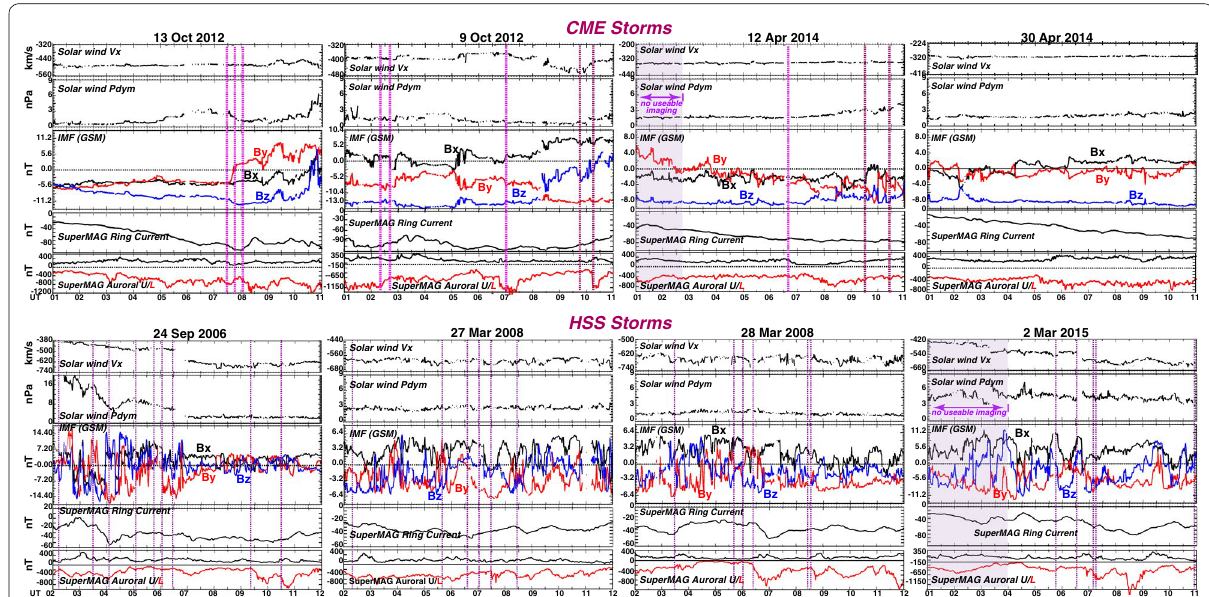
Fig. 2 Solar wind and geomagnetic parameters for the four of our selected CME events having the smoothest southward IMF Bz during the period of ASI viewing. The same parameters are also shown for four HHS storms with fluctuating IMF during their period of ASI viewing. For each storm, vertical dashed lines give all the substorm onsets identified with the ASI array. Magenta dashed line identify the 7 substorm identified during steady, strong southward IMF of the CME storms. Pdym is solar wind dynamic pressure. The SuperMAG ring and auroral U and L indices are the same as the standard ring current Sym‑H and auroral AU and AL indices, except from a large array of available magnetometer